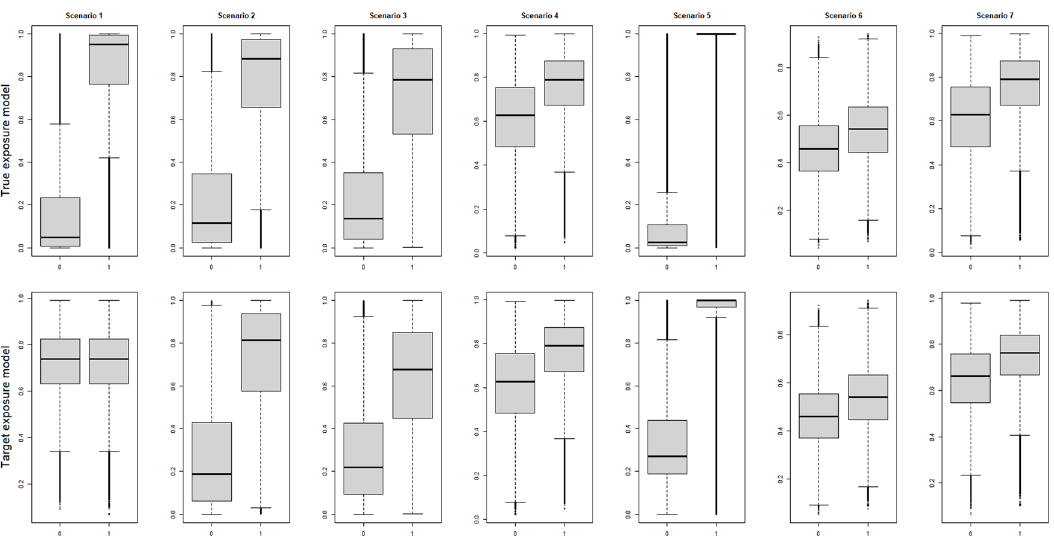
Figure 1: Boxplots of Z P X ˆ 1 ( ∣ ) = according to X , taking either Z as the true causes of exposure or as the target adjustment